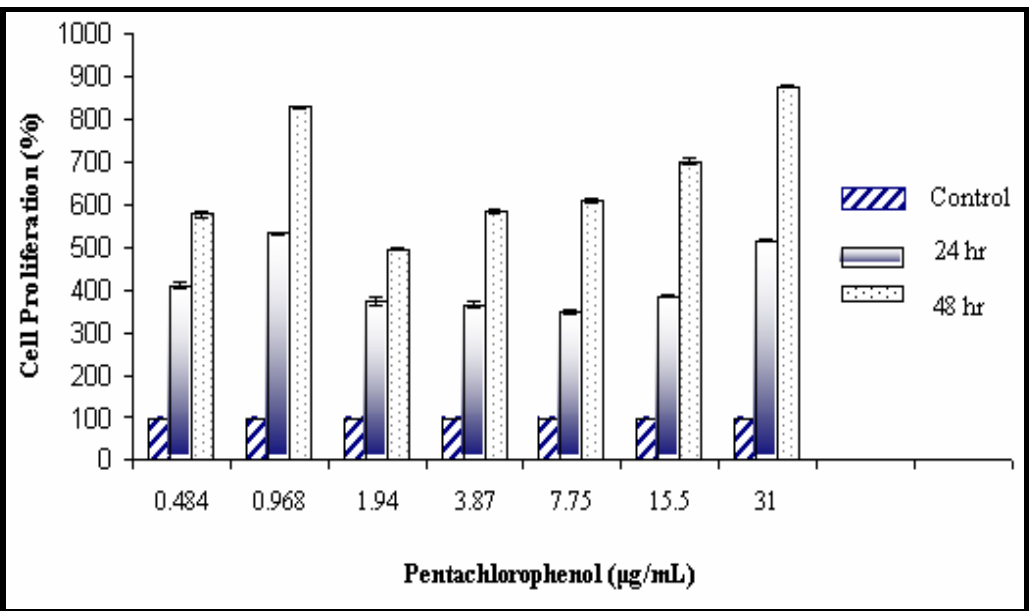
Figure 2: Mitogenic effect of pentachlorophenol on catfish hepatoctes, after 24 hr and 48 hr of exposure. Bars are means + SDs, n=3 with 8 replications per concentration. All values are significantly different from control (0 µg/mL PCP), p <